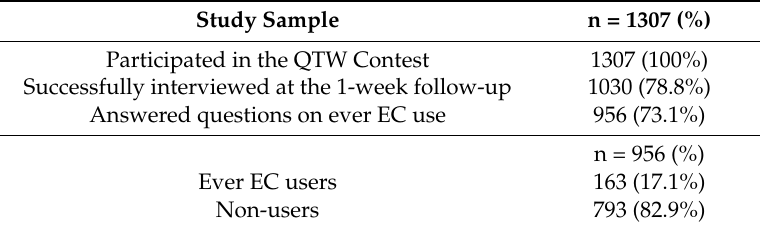
Table 1. No. of smokers participated in the QTW Contest, RCT and included in this study. Study Sample n = 1307 (%) Participated in the QTW Contest 1307 (100%) Successfully interviewed at the 1-week follow-up 1030 (78.8%) Answered questions on ever EC use 956 (73.1%) n = 956 (%) Ever EC users 163 (17.1%) Non-users 793 (82.9%) QTW: “Quit to Win” contest. EC: electronic cigarette.